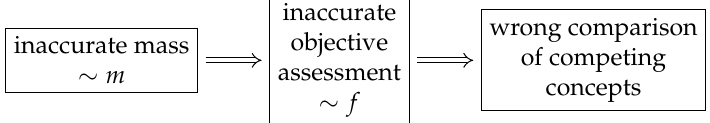
Figure 15. Wrong assessment of the configuration performance.